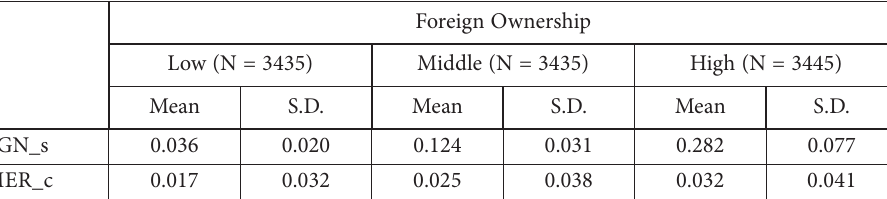
Table 4. Descriptive statistics of the